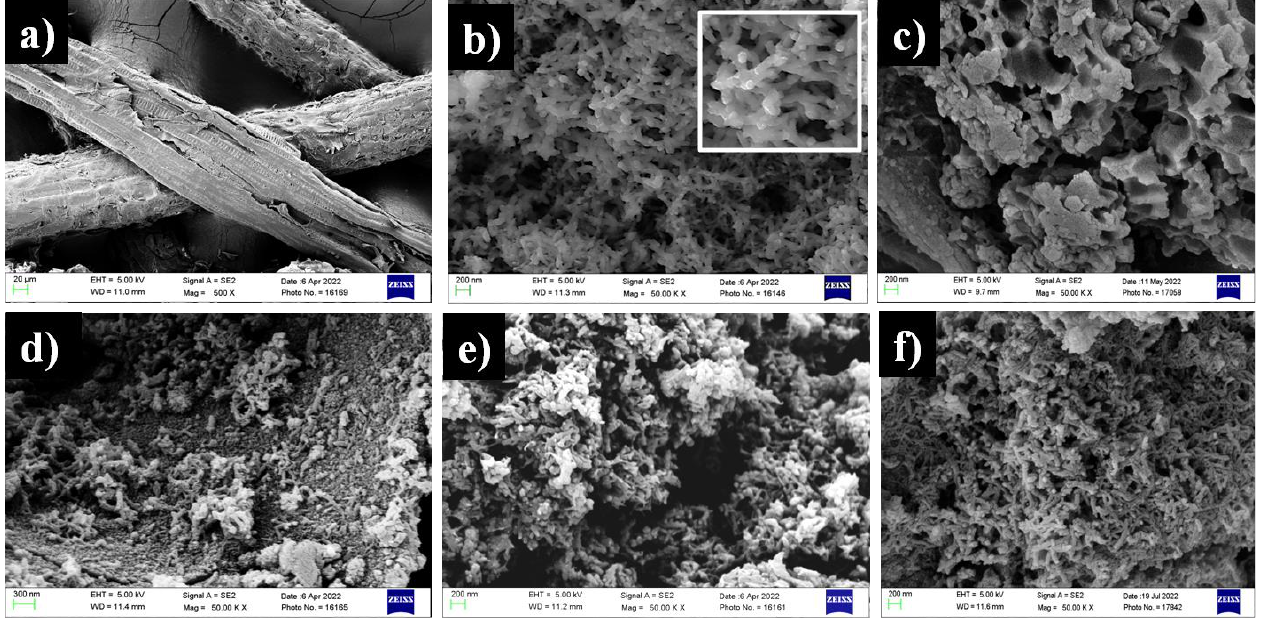
Figure 2. FE-SEM images of ( a ) CF, ( b ) PANI, ( c ) CFC15, ( d ) CFC25, ( e ) CFC50, and ( f ) CFC75. (inset of ( b ) shows the higher resolution image of PANI depicting the rod like shape with agglomerates).